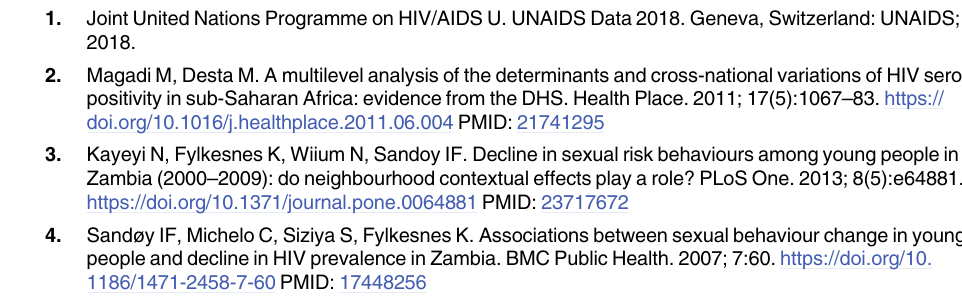
S2 Table. Descriptive statistics of young people aged 15–24 years stratified by sex, 2018 ZDHS. S3 Table. Multilevel logistic regression models for HIV prevalence among young people aged 15–24 years in Zambia, both sexes, 2013–14 and 2018. S4 Table. Multilevel logistic regression Model 5 (including interaction terms) for HIV prevalence among young people aged 15–24 years in Zambia, both sexes, 2013–14 and